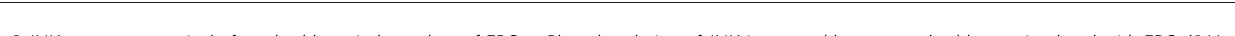
Fig. 3 JNK promotes survival of erythroblasts independent of EPO. a Phosphorylation of JNK in starved human erythroblasts stimulated with EPO (2 U ml − 1 ) at indicated time points. b Representative fl ow cytometry pro fi le (left) and quanti fi cation (right) of apoptotic human erythroblasts induced by SP600125 (20 µ M) for 36 h ( n = 5). c Representative fl ow cytometry plots (left) and quanti fi cation (right) of apoptotic human erythroblasts by JNK1- speci fi c shRNA ( n = 4). d HCT and RBC counts on day 0 ( n = 8) and on indicated time points ( n = 5) in P38 α + / − and P38 α − / − mice treated with vehicle or SP600125. e Number ( n = 4) and apoptosis ( n = 5) of erythroblast subsets at fourth week in P38 α + / − and P38 α − / − mice exposed to vehicle or SP600125. f , g mRNA ( f ) and protein ( g ) expression of JunD from sorted P38 α + / − and P38 α − / − erythroblasts during recovery (day 4) from PHZ-induced anemia. h JunD protein levels in SP600125 (20 µ M) treated human erythroblasts by immunoblotting. i Representative fl ow cytometry pro fi le (left) and quanti fi cation (right) of apoptotic human erythroblasts induced by JunD-speci fi c shRNA ( n = 4). Blots are representative of three independent experiments. Data are shown as mean ± s.e.m. * P < 0.05 (two-tailed unpaired Student ’ s t